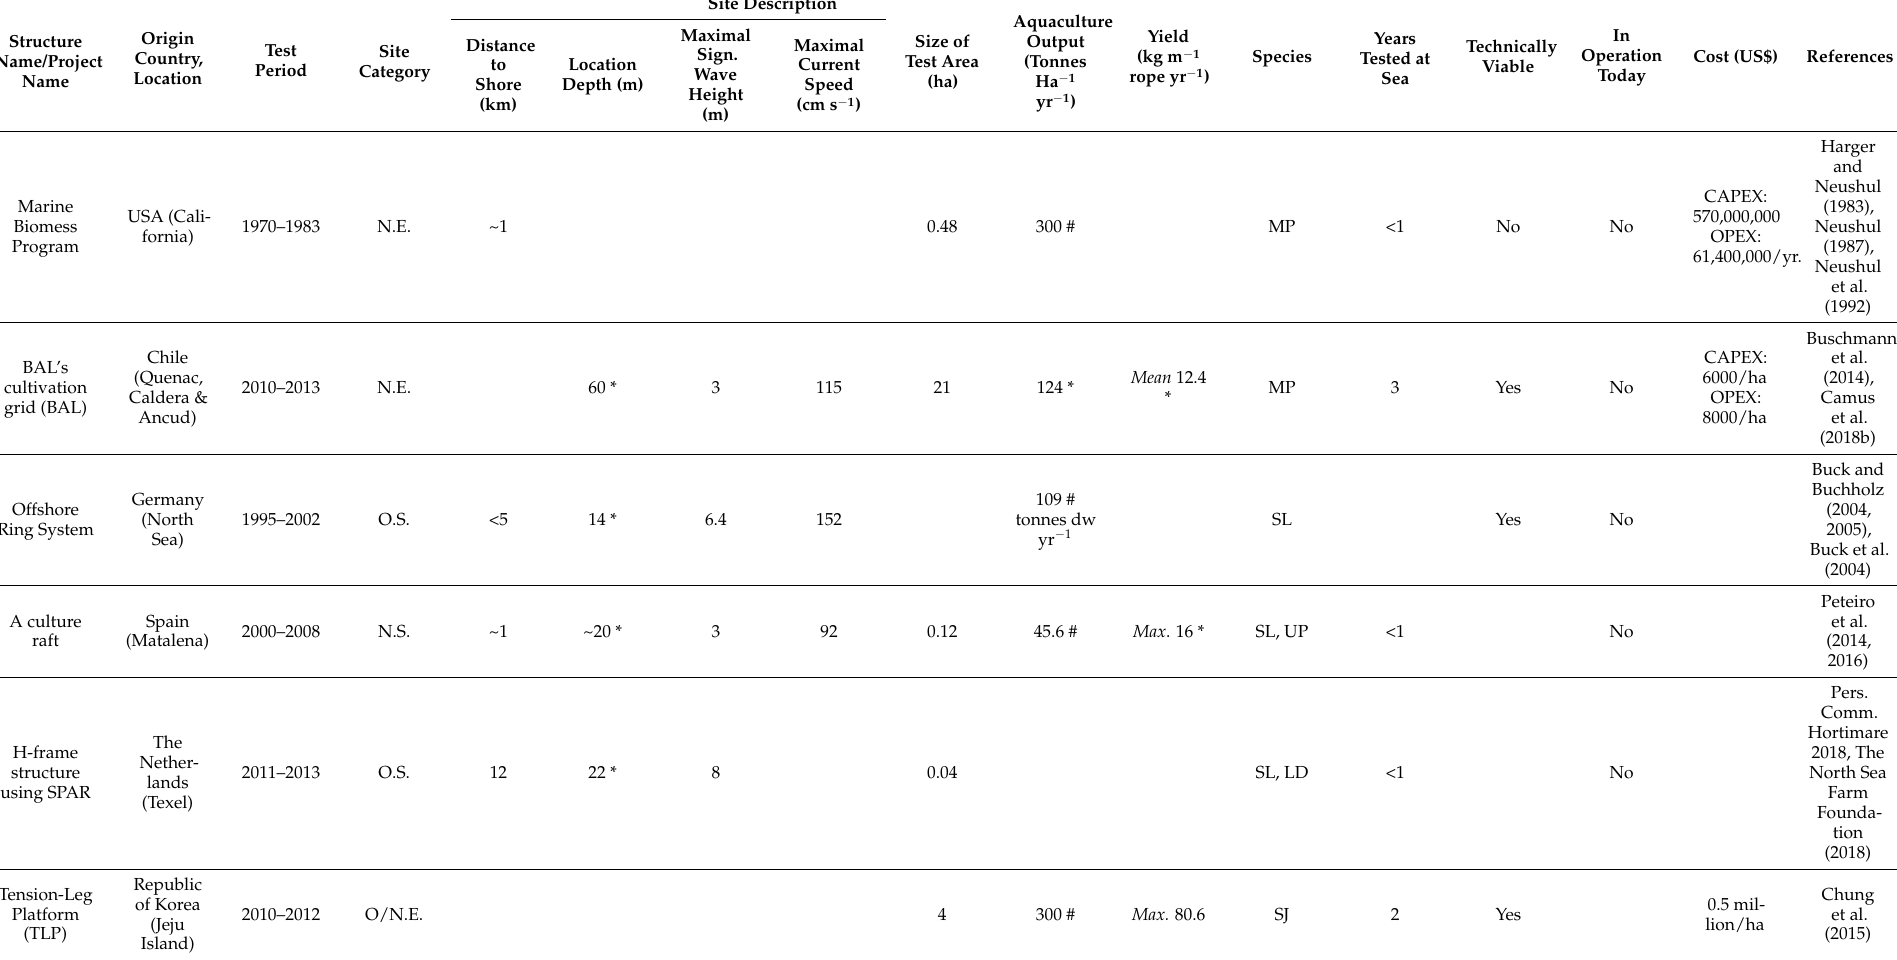
Table 3. Referenced copy of qualitative assessment of offshore macroalgal cultivation structures. Reproduced with permission